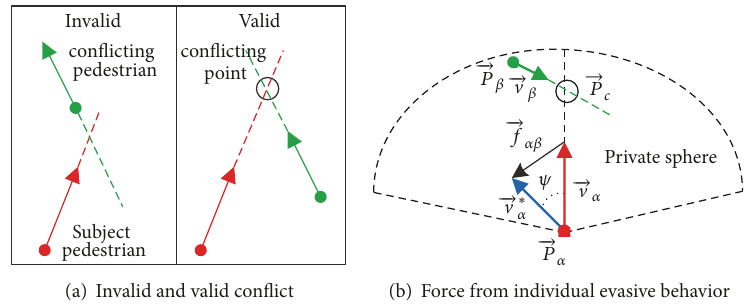
Figure 5: Forces on individuals avoiding